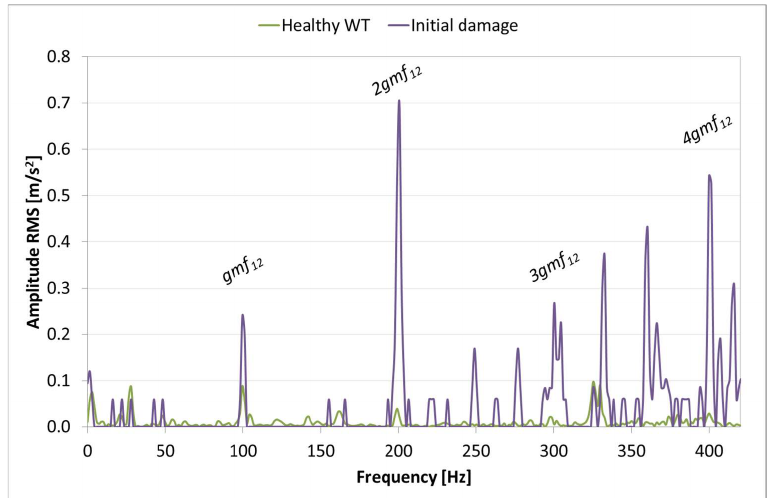
Figure 15. Comparison between one spectrum in healthy condition and another one with initial gearbox damage corresponding to gearbox 3 measurement.